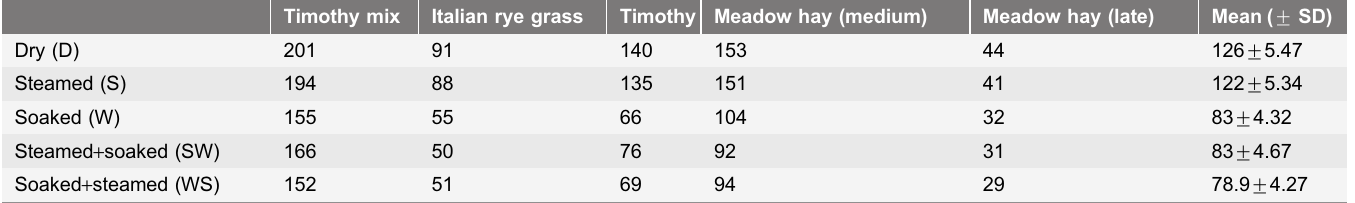
Table 3. Mean contents of water soluble carbohydrate (WSC)(g/kg DM) in 5 different types of UK hay when subjected to 5 different wetting treatments.